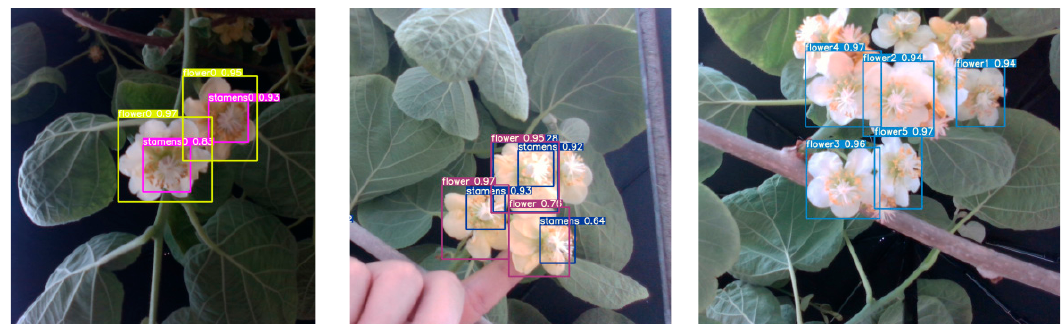
Figure 11. Images after data enhancement.